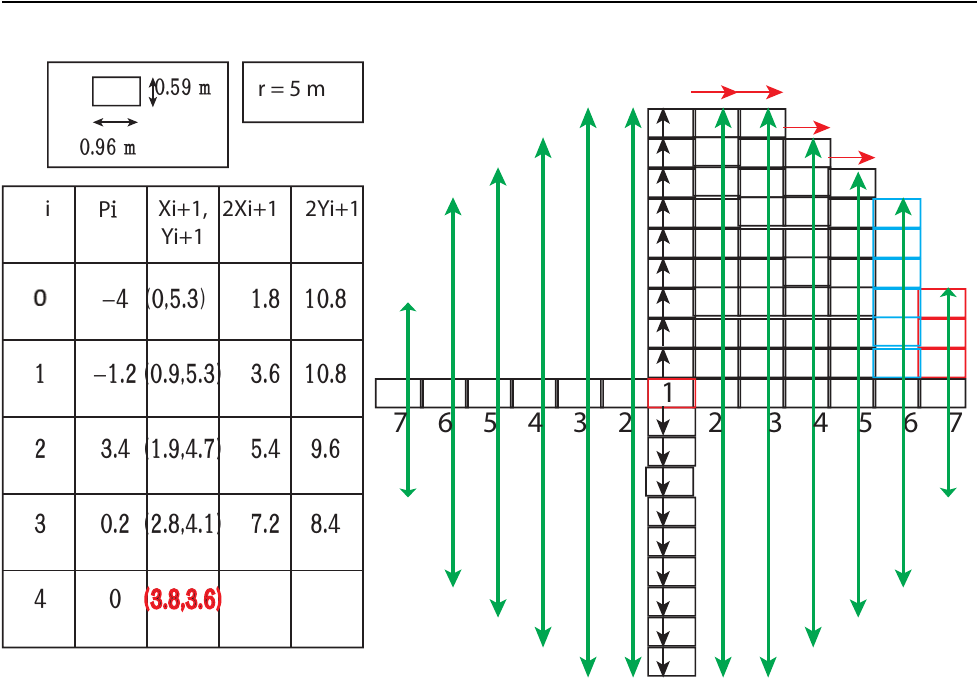
Figure 9. Modified midpoint circle